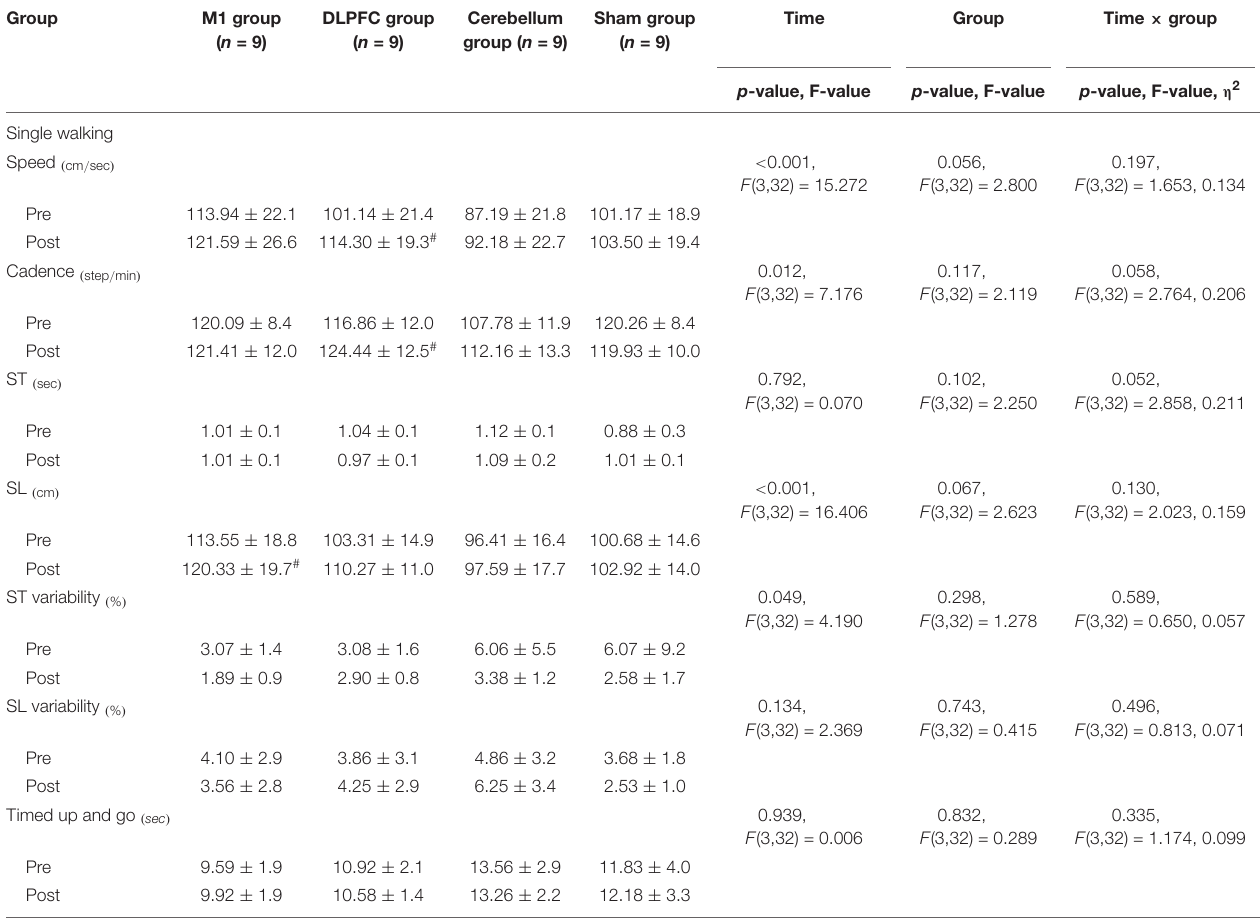
TABLE 4 | Single walking and timed up and go performance after different tDCS interventions. Group M1 group DLPFC group ( n = 9) ( n =